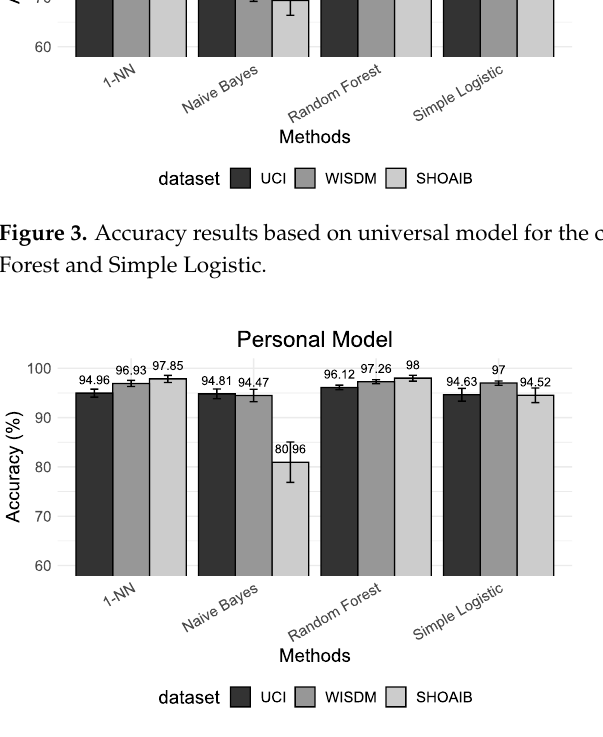
Figure 4. Accuracy results based on personalized model for the classifiers 1-NN, Naive Bayes, Random Forest and Simple Logistic.